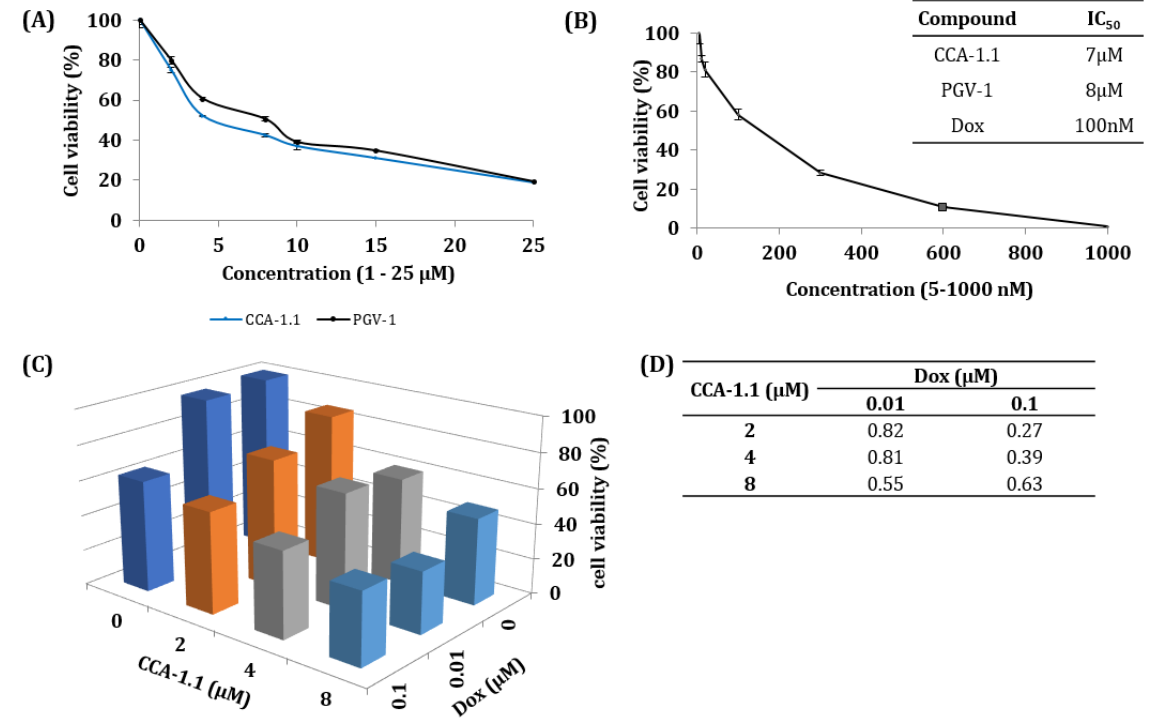
Figure 2. Cytotoxic effect on T47D growth profile of CCA-1.1, PGV-1 (A), doxorubicin (Dox) (B), combination of CCA-1.1 with Dox (C), and CI values. An amount of 7 × 10 3 cells/well were treated by CCA-1.1, PGV-1, and doxorubicin for 24h as described in the Method section. The data was presented as average ± standard error (SE) ( n =